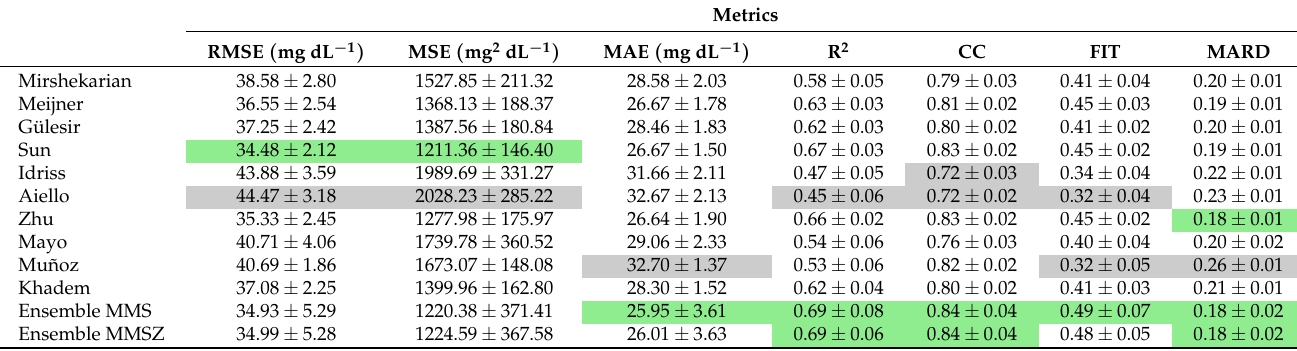
Table 12. Results of the ten NN models for each performance metric for ph = 60min. Green cells in each column highlight the model with the best performance, whereas the grey-colored cells are the worst.